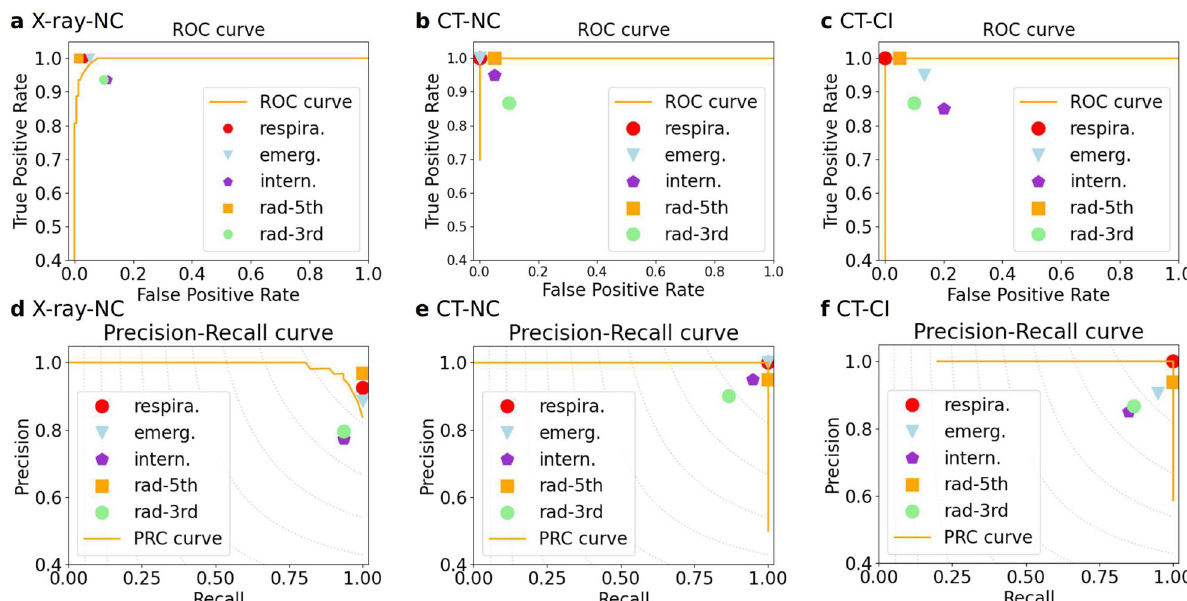
Fig. 4 ROC and PRC curves for the CNNCF of the experiments A-C. NC indicates that the positive case is a COVID-19 case, and the negative case is *Normal. CI indicates that the positive case is COVID-19, and the negative case is in fl uenza. The points are the results of experts, corresponding to the results in Tables 2 and 3. The background gray dashed curves in the PRC curve correspond to the iso-F1 curves. a ROC curve for the NC using X-data. b ROC curve for the NC using CT-data. c ROC curve for the CI using CT-data. d PRC curve for the NC using X-data. e PRC curve for the NC using CT-data. f PRC curve for the CI using